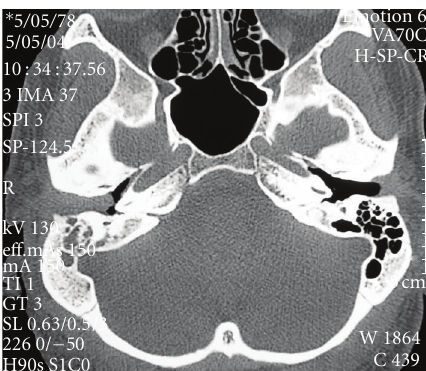
Figure 1: Axial CT of both temporal bones. The mastoid air cells on the right appear filled with a soft tissue density as well as the external auditory canal. The middle ear is filled with air.